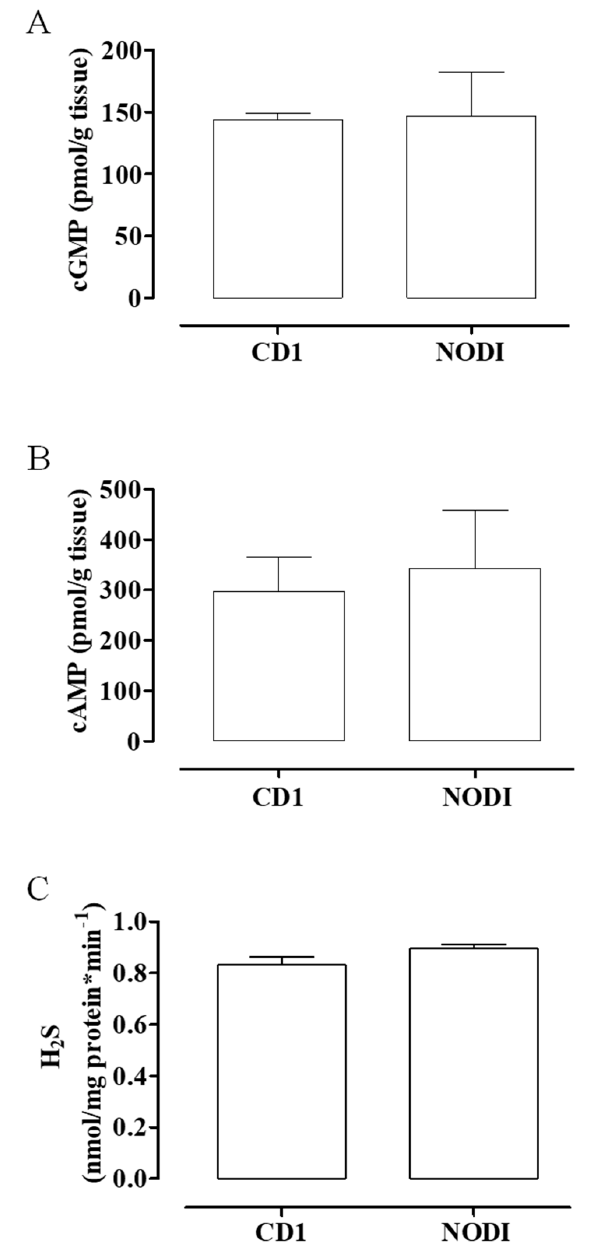
Figure 1. cGMP, cAMP, and H 2 S levels in CD1 and NODI mouse uteri. The basal levels of cGMP ( A ), cAMP ( B ), and H 2 S ( C ) were not significantly different between CD1 (control mice (CTR)) and NODI mice. NODI mice have normal glucose levels.